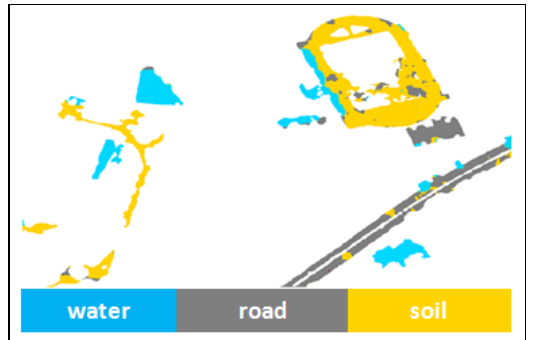
Figure 13. The classification result of the mixture land-cover